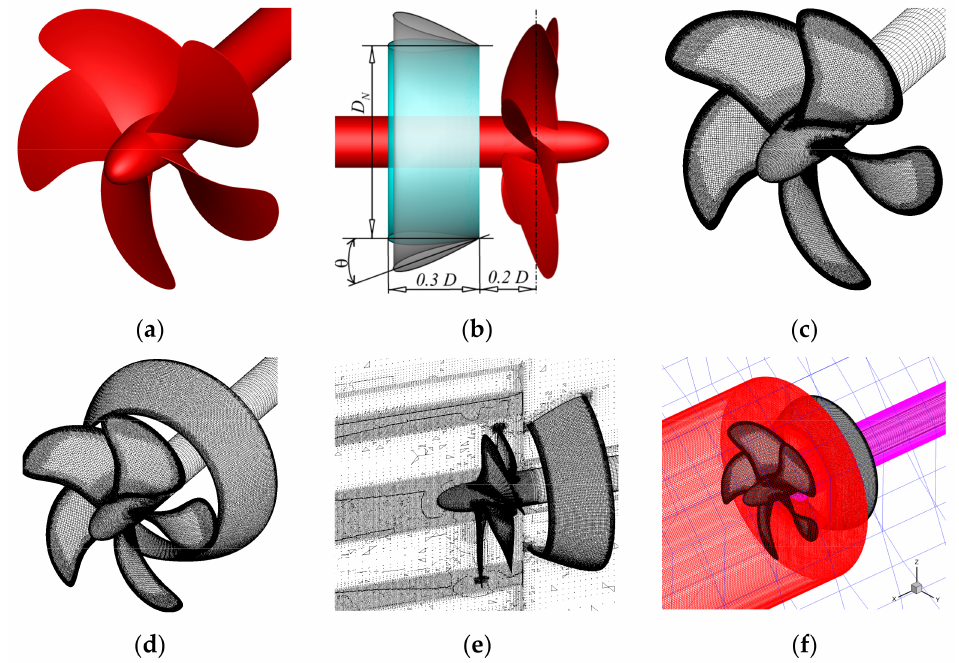
Figure 1. Geometries and computational meshes. ( a ) KP505 propeller geometry, ( b ) computational set-up for the nozzle-propeller computation, ( c ) single propeller working in open water, ( d ) surface mesh for the nozzle-propeller computational case, ( e ) computational mesh in the symmetry plane, ( f ) sliding grids for the nozzle-propeller